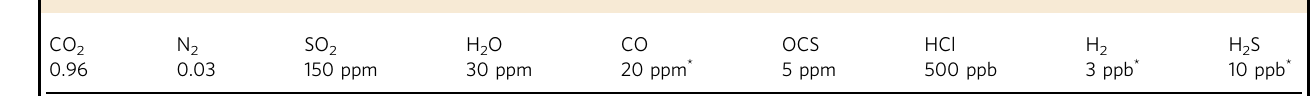
Table 1 Initial surface abundances for the fi ducial atmosphere 6